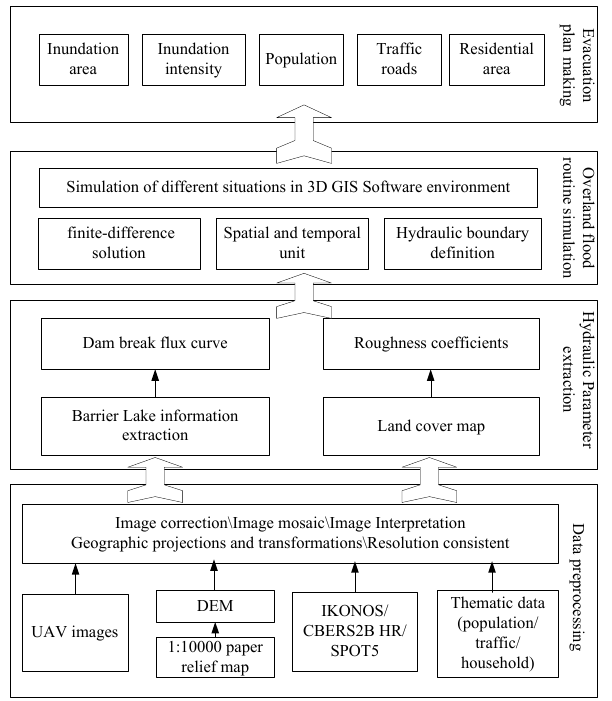
Fig. 2. Technical framework for dam break flood simulation and preliminary planning.